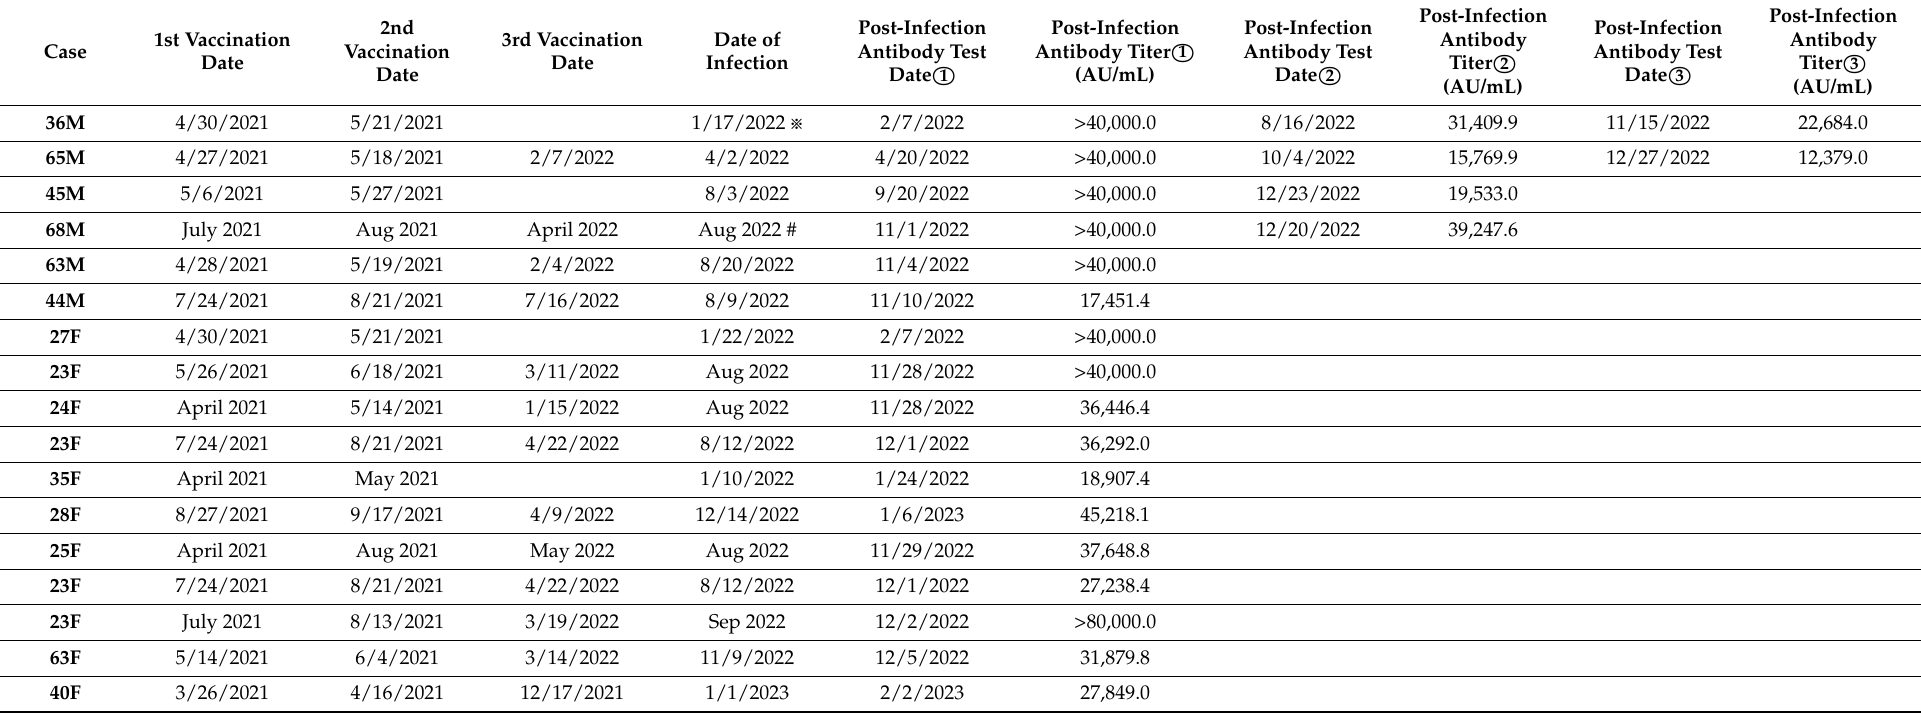
Table 4. Cases of spontaneous COVID-19 infection after two or more doses of